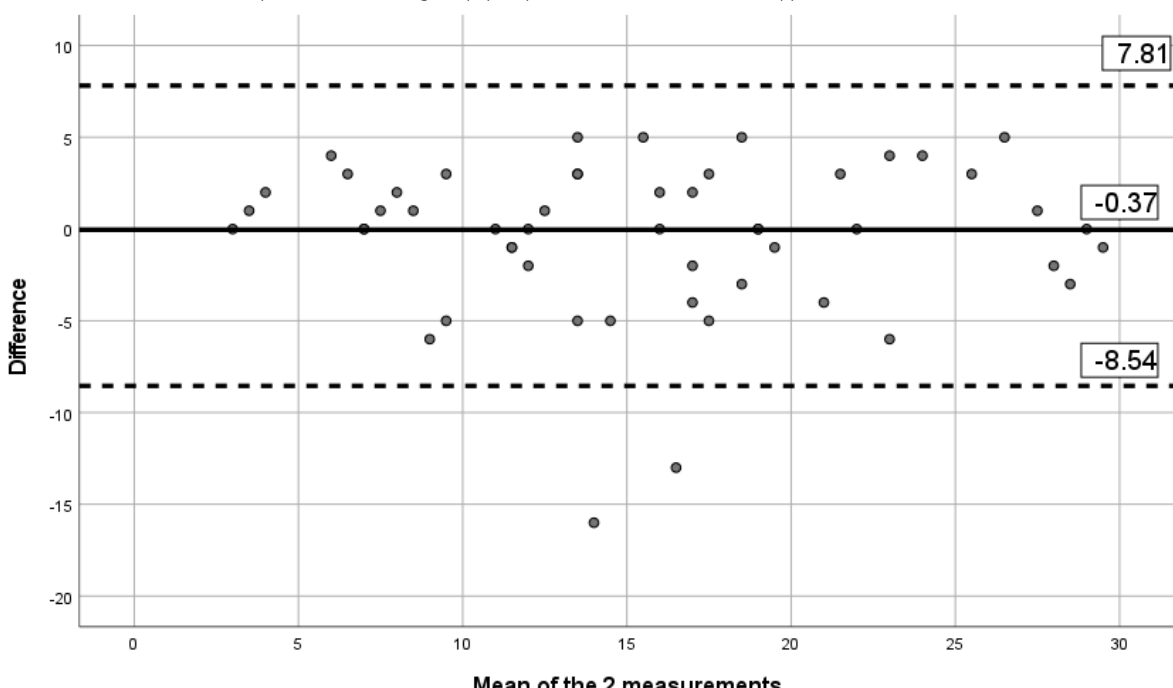
Figure 10. Bland-Altman limits for painDETECT using the paper questionnaire and the mobile